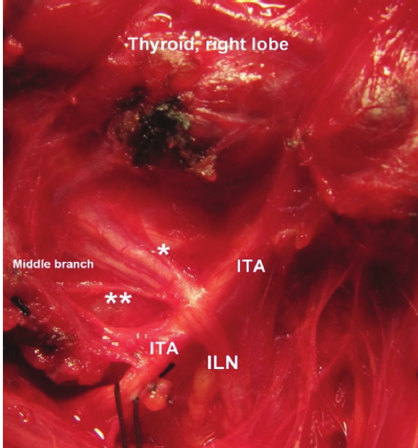
Figure 2: Extralaryngeal terminal trifurcation of the right ILN. Division of the nerve occurs at neurovascular crossing. ∗ Anterior branch, ∗∗ Posterior branch. Figure 3: Terminal division of theleft inferior laryngeal nerve (ILN) occurs at arterial segment (Type 1). ∗ Anterior branch. ∗∗ Posterior branch. ITA: inferior thyroid